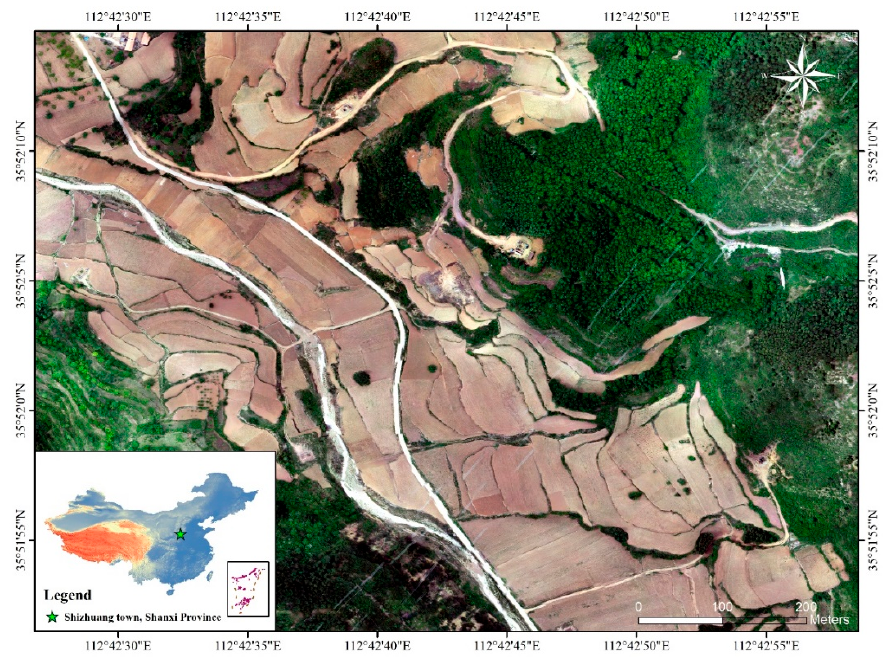
Figure 1. Geographical location and optical image of the study area in southeast of Shanxi Province, China.